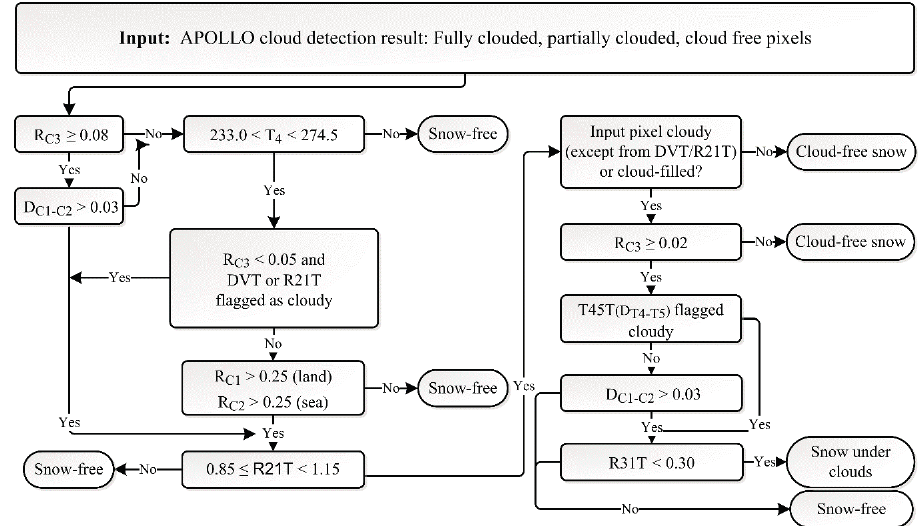
Figure 3. AVHRR Processing Over Land, cLoud and Ocean (APOLLO) snow and ice detection scheme (R C3 : Reflectance in channel 3; D C1-C2 : Difference between channel 1 and channel 2; T 4 : brightness temperature in channel 4; DVT: Dynamic visible threshold; R21T: ratio between channel 1 and channel 2—cloud test; R31T: Ratio between channel 3 and channel 1; T45T: Difference between brightness temperatures of channels 4 and 5); all information taken from